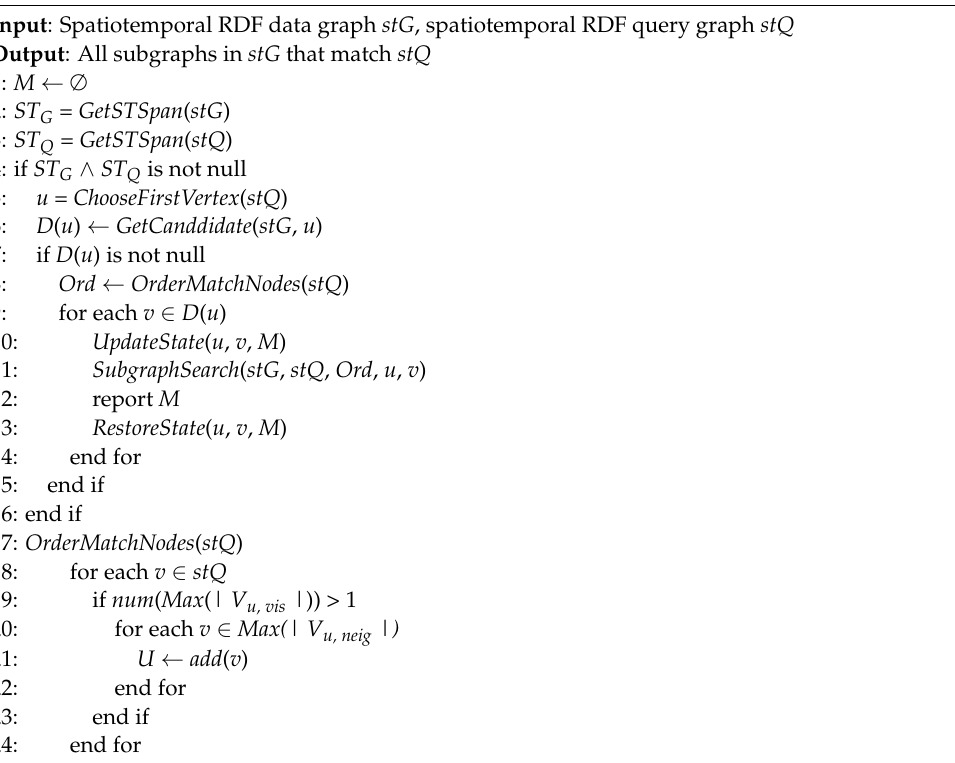
Algorithm 2: Spatiotemporal RDF Query Algorithm